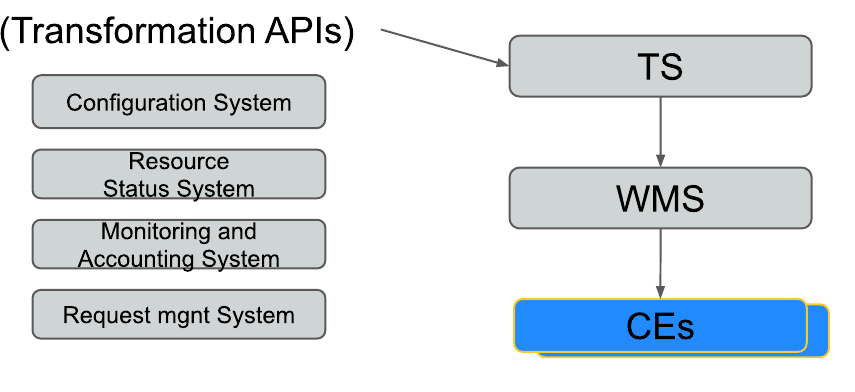
Figure 2. Productions management through DIRAC Transformation and Workload Management Sys- tems